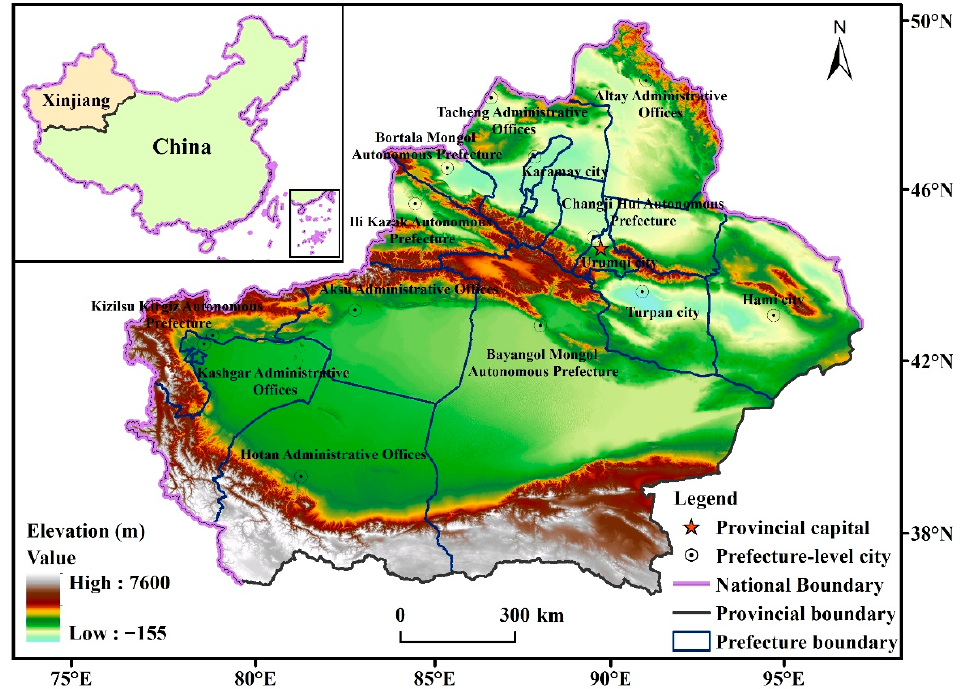
Figure 1. The geographic location of Xinjiang and its administrative division.